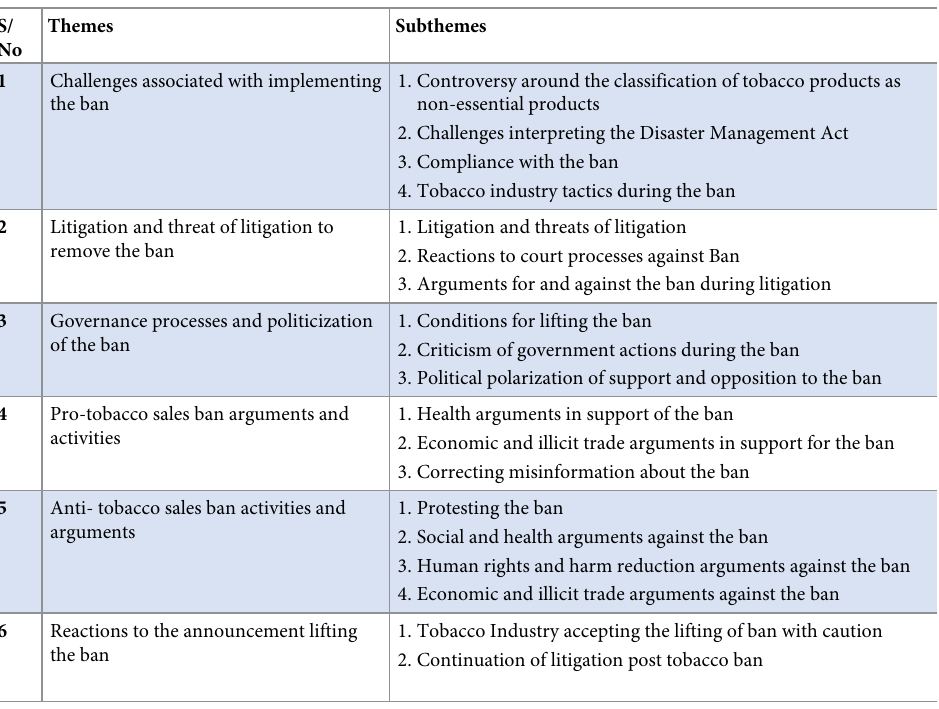
Table 2. Summary of themes and